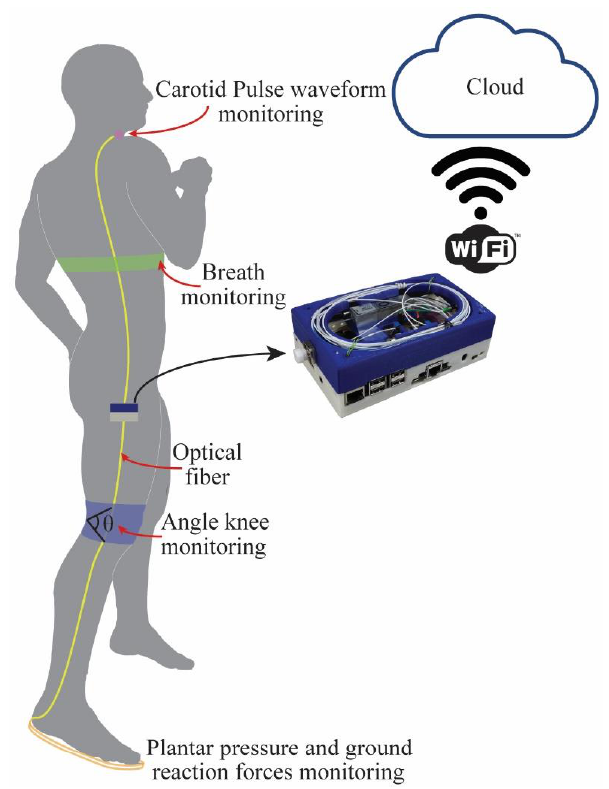
Figure 12. Schematic representation of the architecture for remote health monitoring using the proposed portable-energy efficient-interrogator.